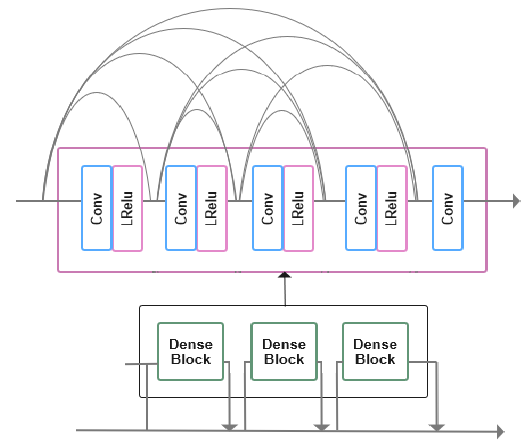
Figure 3. Residual Dense Network Structure.